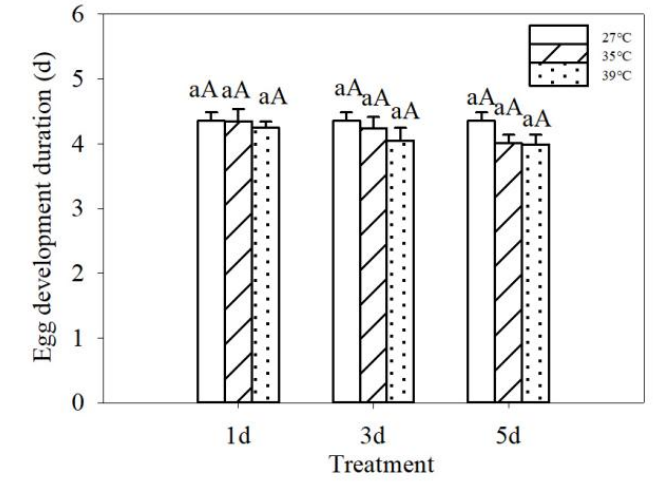
Figure 1. Egg development duration of Leptinotarsa decemlineata after the eggs were repeatedly exposed to different high temperature (35 ◦ C and 39 ◦ C) for 4 h during 1, 3 and 5 days. Data are expressed as mean ± SE. Data followed by the same letter in a histogram are not significantly different ( p > 0.05).